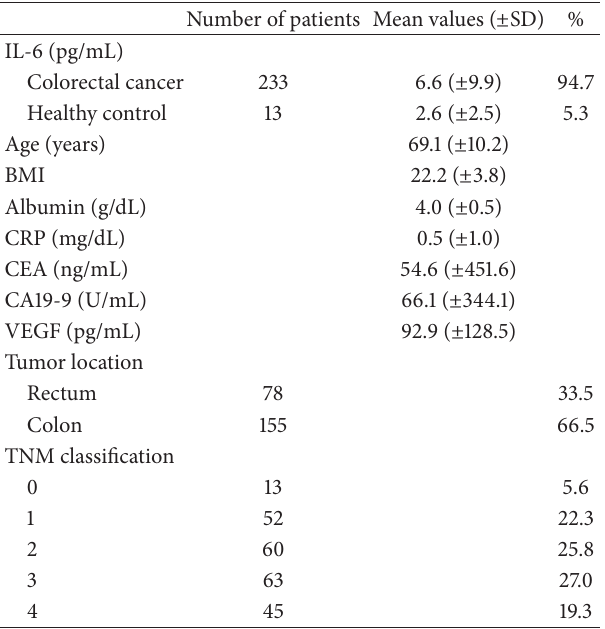
Table 1: Characteristic of the study patients ( 𝑛 = 233